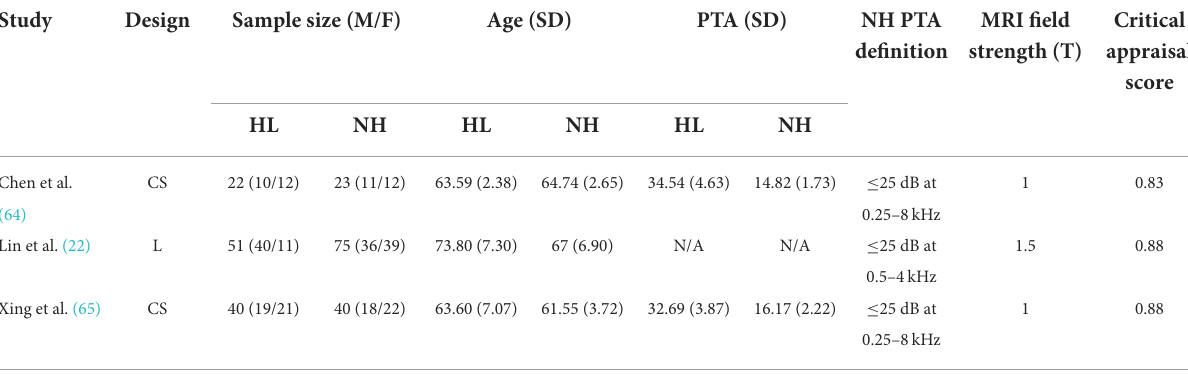
TABLE 3 Means, and standard deviations where applicable, of the data extracted for papers used in the whole-brain analysis.